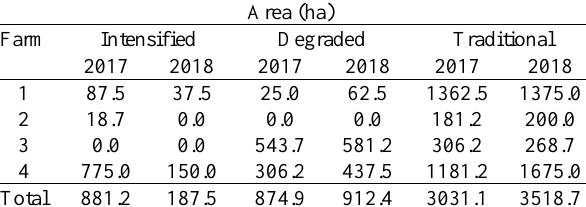
Figure 4. Example of distance matrix for year 2017, over the Table 3. Total pasture areas of each class in the four farms region of the four farms visited - upper: Farms 1 and 2; middle: Farm 4; and bottom: Farm 3